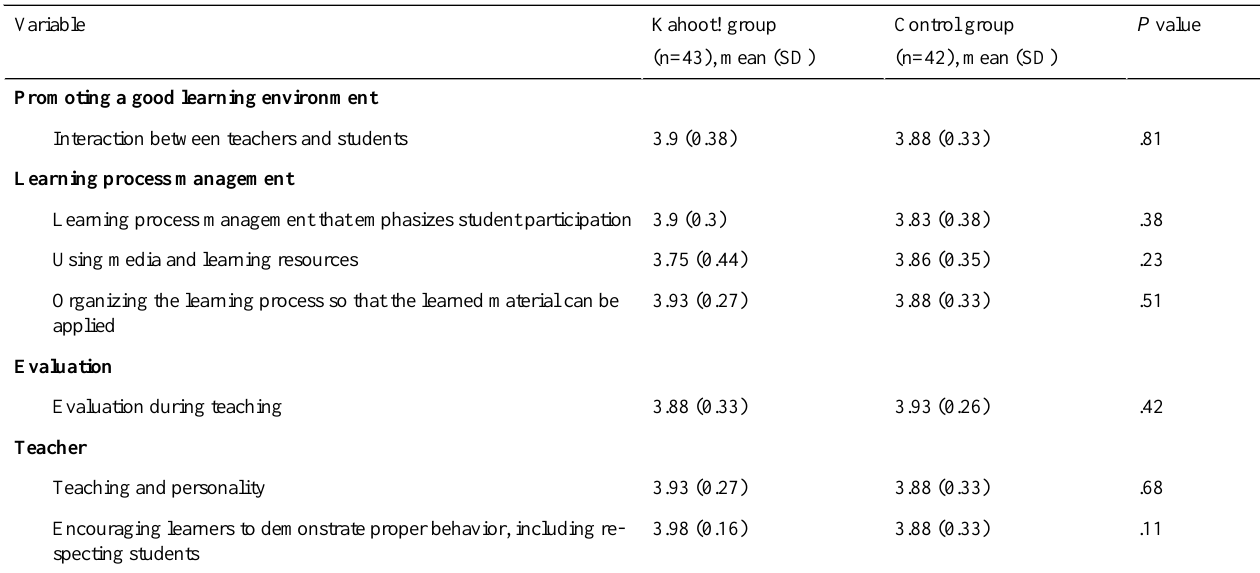
Table 1. Mean student satisfaction scores for the 2 groups (N=85). Scores ranged from 0-4, with 0 indicating low satisfaction and 4 indicating high